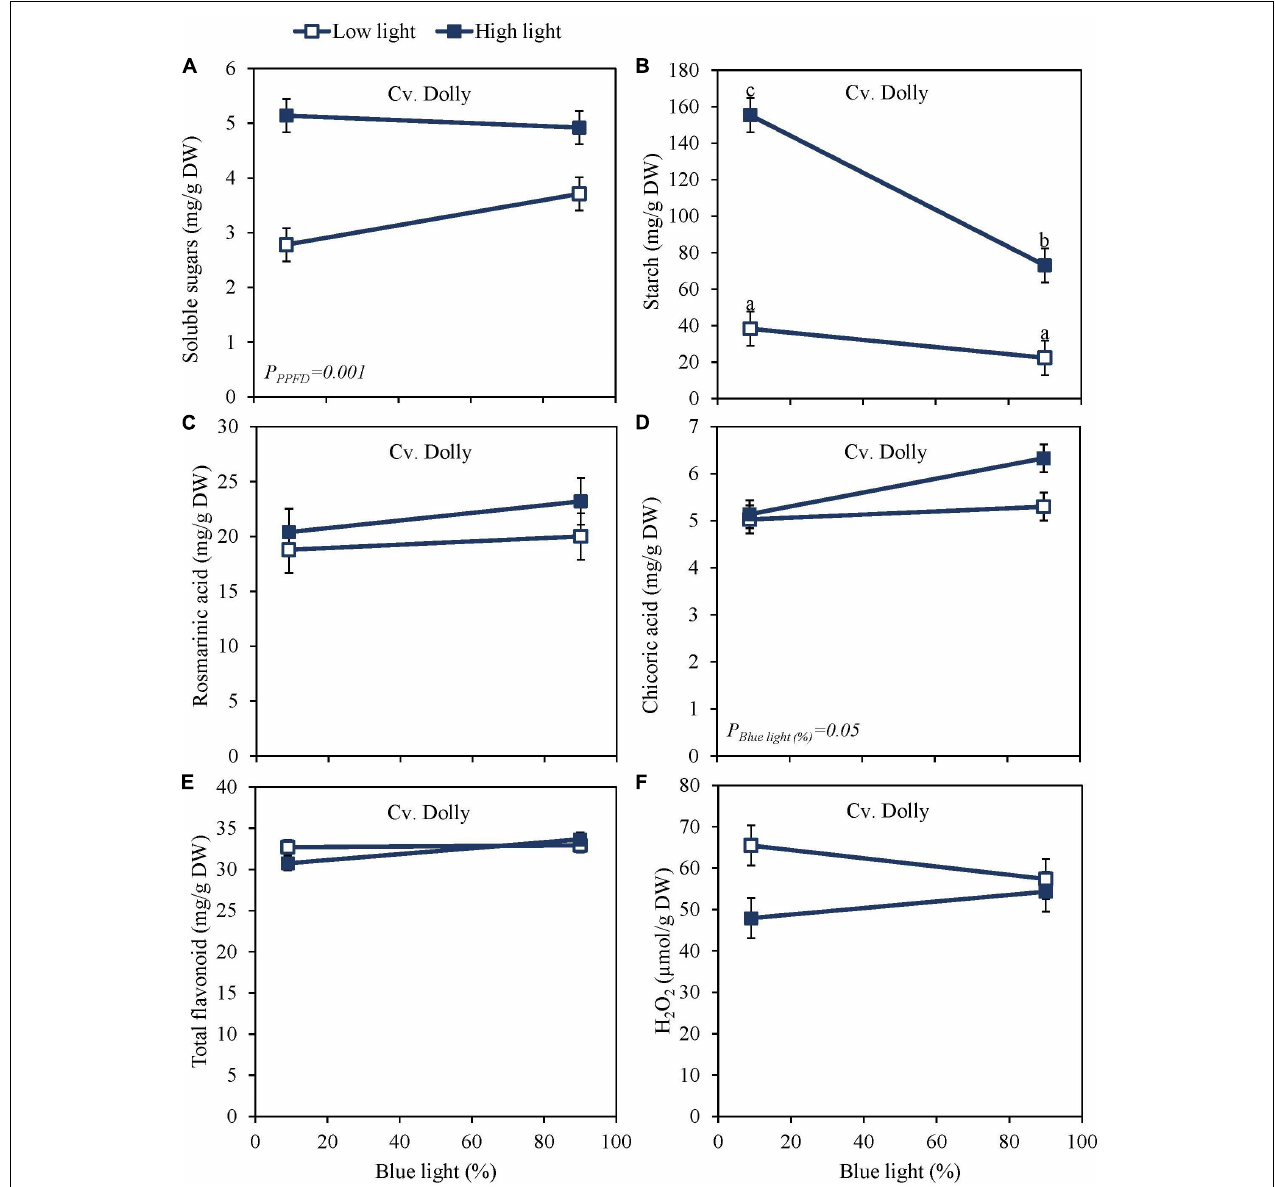
FIGURE 2 | Metabolite levels at harvest in basil, the green cv. Dolly were exposed to either 9% or 90% blue light at low PPFD (100 µ mol m − 2 s − 1 ) (open symbols) or high PPFD (300 µ mol m − 2 s − 1 ) (closed symbols) applied the last 5 days before harvest as EOP treatments. Before EOP treatments plants were grown under red-white light (PPFD of 200 µ mol m − 2 s − 1 , 9% blue) for 30 days. (A) Soluble sugars (sum of glucose, fructose, and sucrose), (B) starch, (C) rosmarinic acid, (D) chicoric acid, (E) total flavonoids, (F) hydrogen peroxide (H 2 O 2 ). All values are expressed per gram dry weight in the leaves. The data are means of three blocks ( n = 3) (i.e., per block four replicate plants). Standard errors of means are shown as error bars. Significance of the main effects percentage of blue light and PPFD ( α = 5%) are shown. Letters indicate and interactive effect between the two main effects (percentage of blue light and PPFD), (Experiment